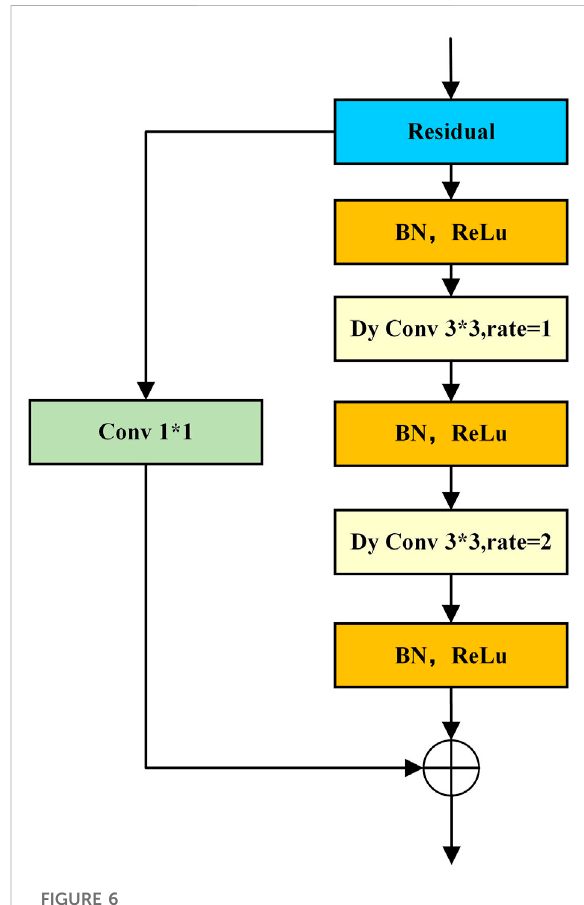
FIGURE 6 Schematic of the res-double dynamic convolution